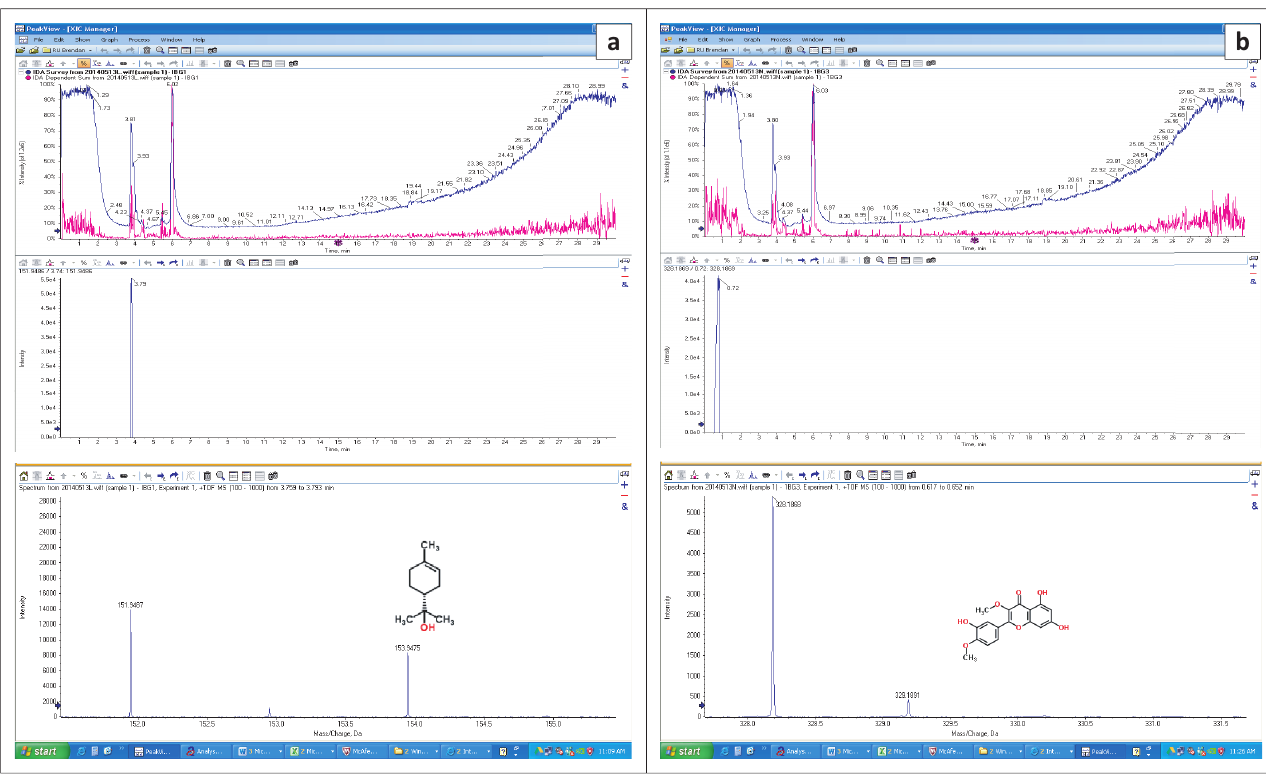
FIGURE 7: Liquid chromatography–mass spectroscopy chromatogram of clausine B and clausenocoumarine.